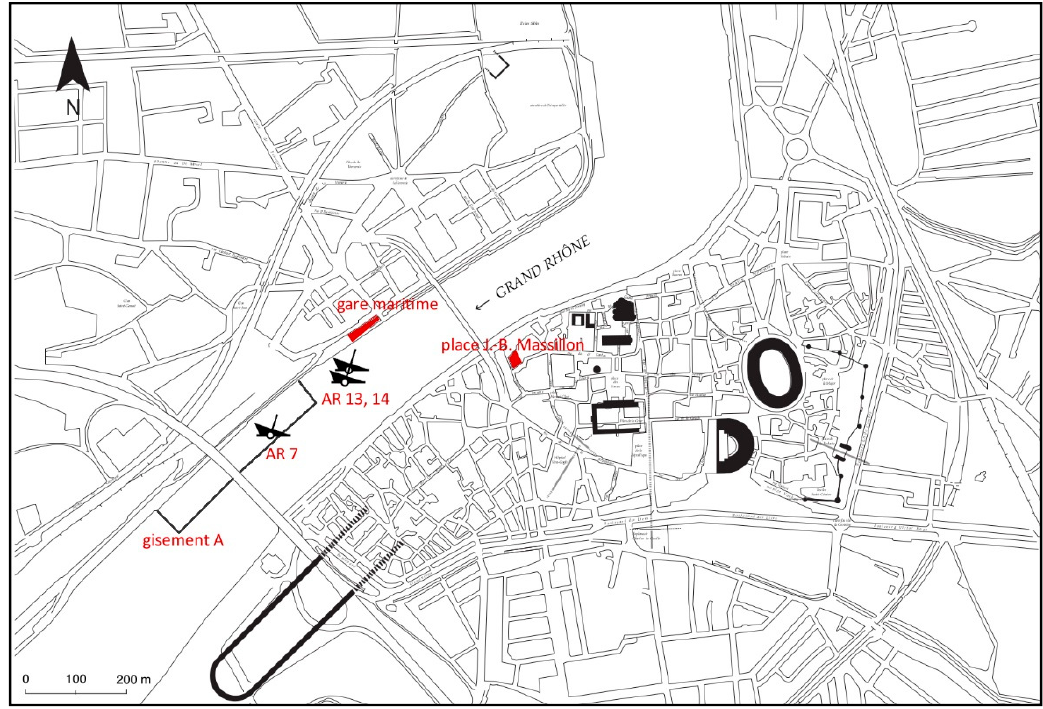
Figure 4. Plan of Arles with the most important sites mentioned in the text (after M. Heijmans [27] (pl. I)).